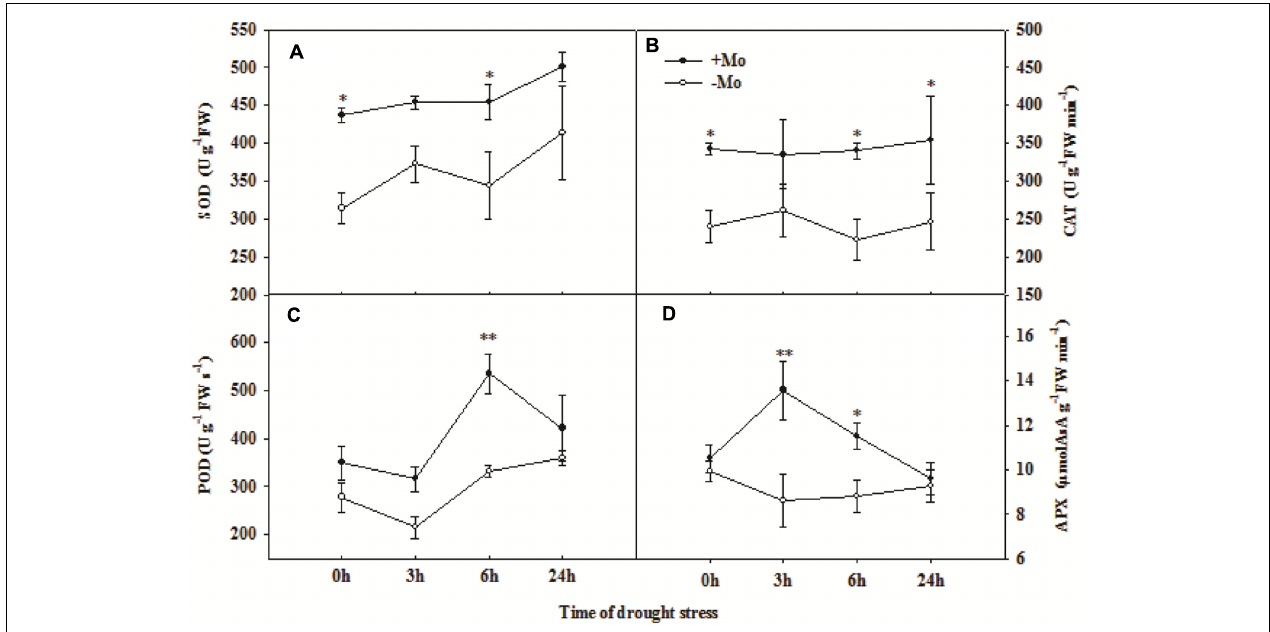
FIGURE 2 | Effects of molybdenum (Mo) application on superoxide dismutase (SOD; A ), catalase (CAT; B ), peroxidase (POD; C ), and ascorbate peroxidase (APX; D ) in wheat leaves under polyethylene glycol 6000-simulated drought stress (PSD). –Mo and +Mo treatments represent wheat grown in modified Hoagland solution with 0 and 1 µ M Mo, respectively. 0, 3, 6, and 24 h represent 0, 3, 6, and 24 h of polyethylene glycol 6000 (PEG) stress, respectively. Asterisk ( ∗ ) indicates significant difference between –Mo and +Mo treatments by ANOVA followed by Duncan-test multiple comparisons ( ∗ P < 0.05, ∗∗ P < 0.01; n = 3).